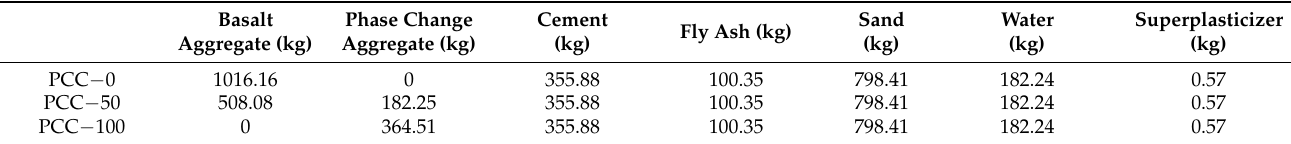
Table 5. Mixture proportions of phase change concrete.